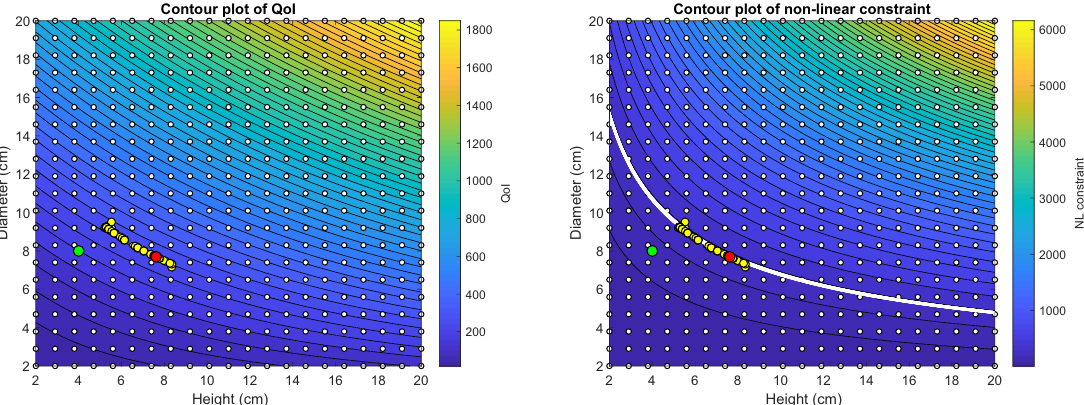
Figure 6. Left image: contour plot of the QoI (total surface). Right image: contour plot of the non-linear constraint (volume); in the image, the white line represents the range where the volume is 354 cm 3 < Volume < 356 cm 3 . In both images, the green circle represents the starting point, the red circle represents optimal value, the yellow circles represent the path followed by the optimization algorithm (note that the gradient evaluations are not plotted), and the white circles represent the sampling